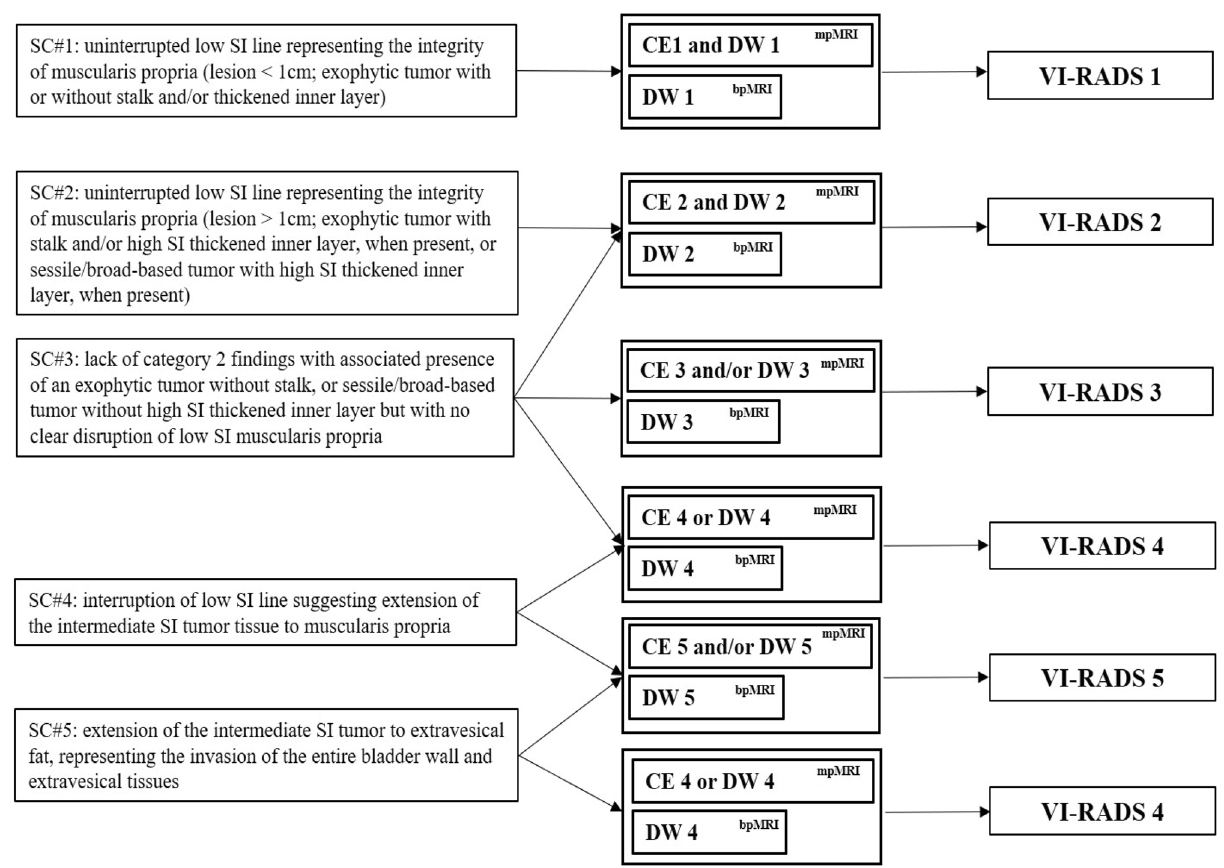
Figure 1. Summary of the schematic representation of the bp- and mpVI-RADS scoring interpretation. A five-point biparametric VI-RADS (bpVI-RADS) score is generated using the individual T2WI and DWI. The T2-weighted sequence is the dominant sequence, and the diffusion-weighted sequence is considered as a first pass guide. For categories 1–3, the “first pass scoring” T2 sequence should be considered. For categories 4 and 5, the dominant sequences (i.e., when image quality is optimal) are present in DWI for bpVI-RADS, DWI (first) and DCE (second; especially if the DWI is suboptimal) for mpVI-RADS. bpMRI biparametric MRI, DW diffusion-weighted category, DWI diffusion-weighted imaging, mpMRI multiparametric MRI, SC structural category, SI signal intensity, VI-RADS Vesicle Imaging-Reporting and Data MR image interpretation. For comparison between MRI images, two urogenital radiologists with > 10 years